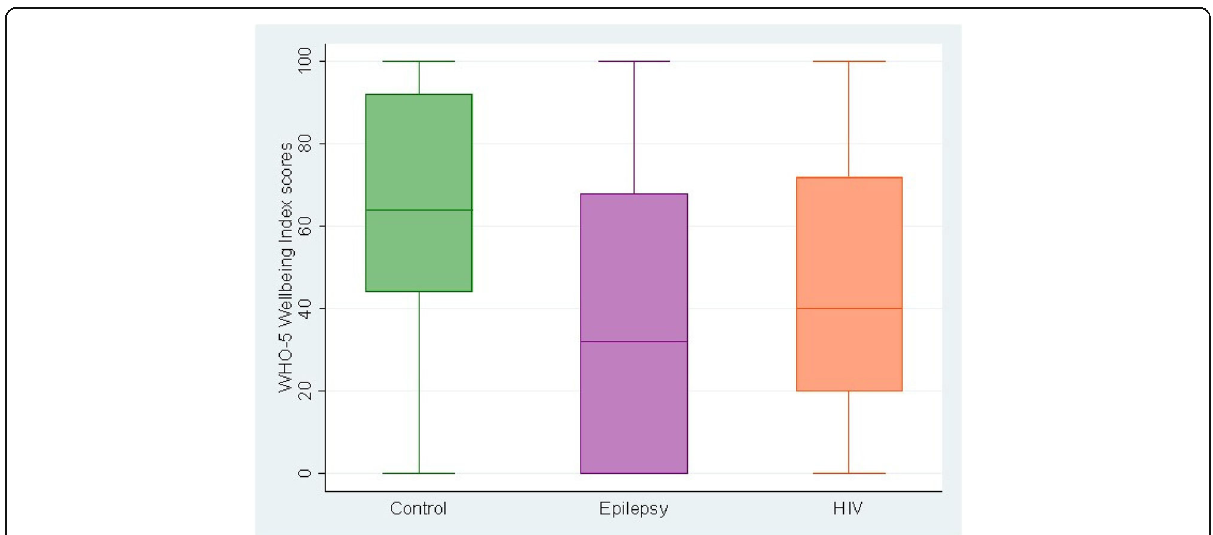
Fig. 1 A box plot of WHO-5 mean scores across the three participant study